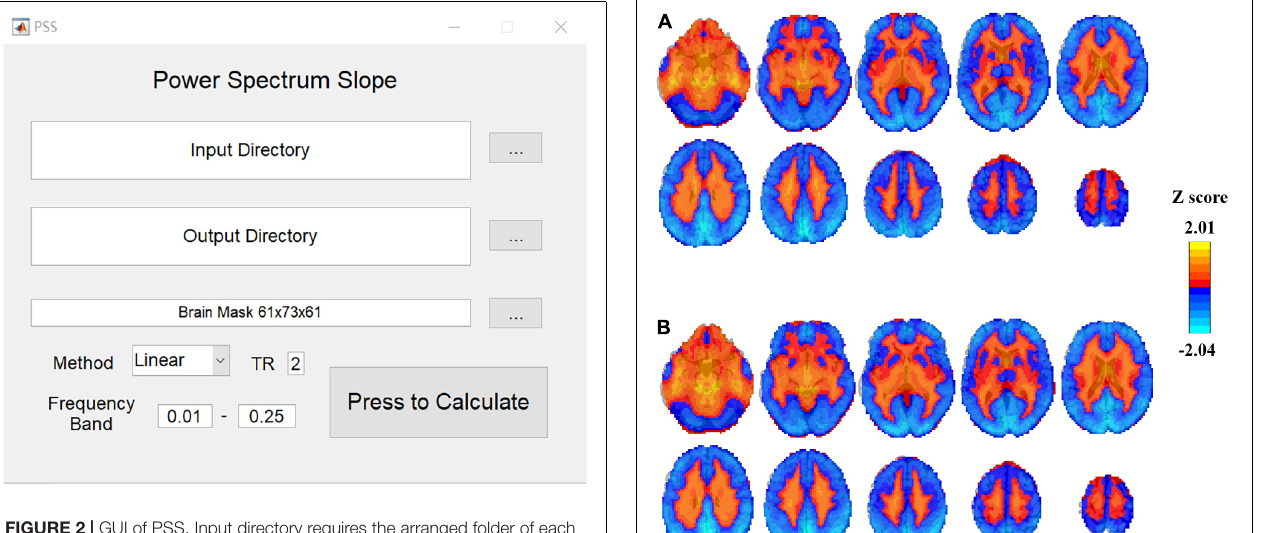
FIGURE 2 | GUI of PSS. Input directory requires the arranged folder of each subject (e.g., subj001, subj002 ... ). In each subject’s folder, only one preprocessed 4-D file is provided. Please note that filtering is forbidden. PSS toolkit will generate a pair of output images for each subject: the original coefficient image and the individual Z-transformed image.